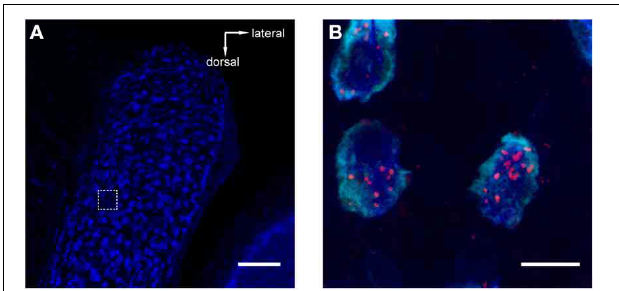
blue = Nissl. (A) Image of AVCN in Nissl only to highlight the globular shapes of cells in the approximate location where globular bushy cells (GCBs) are expected. The dashed square indicates the area from which the magnification in (B) was imaged. The image is a maximum projection of a 80 µ m stack. (B) Maximum projection computed from a sub-stack through the mid-sections of 3 labeled GBCs (spanning a total of 9 µ m). Note the punctate labeling of the cell bodies. Scale bar for (A) : 100 µ m, for (B) : 10 µ m; 4.6 × digital